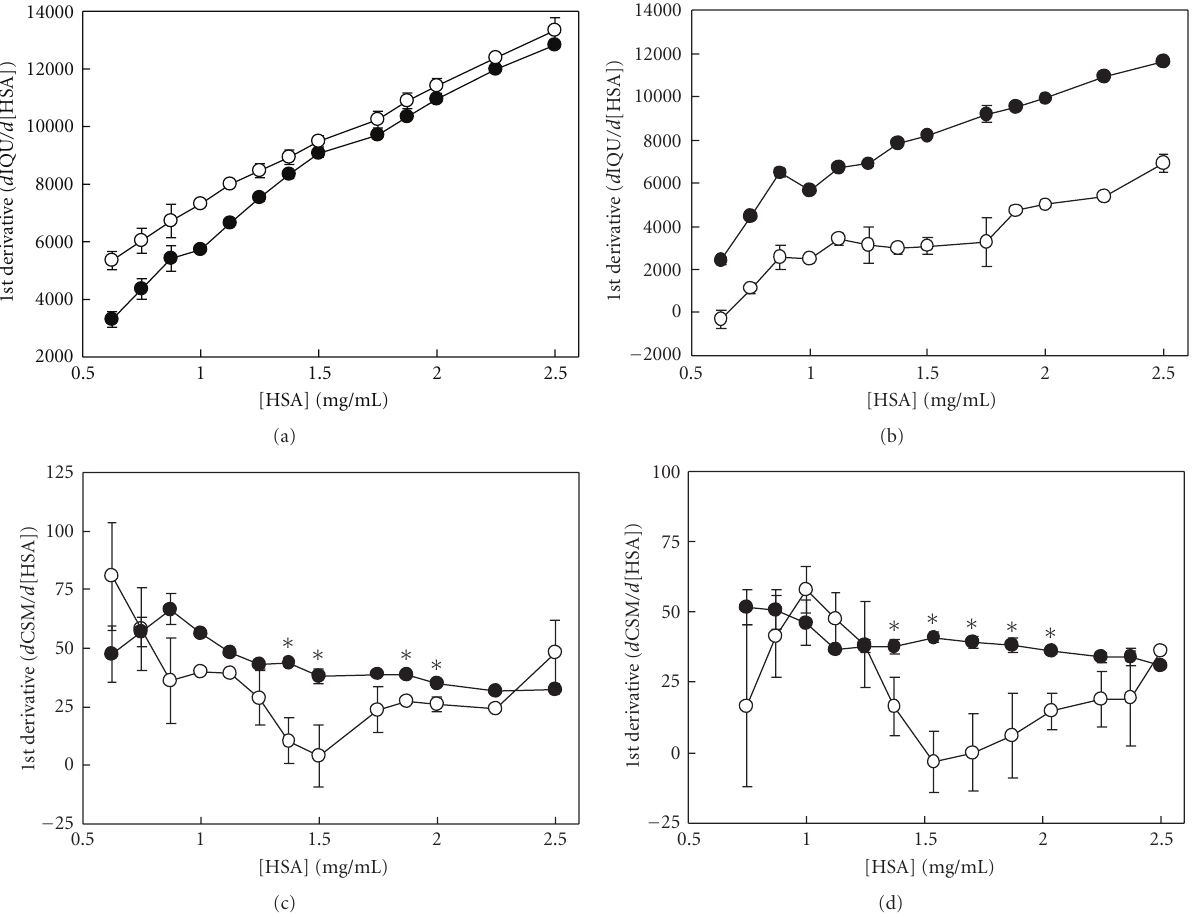
Figure 3: E ff ects of sevoflurane and isoflurane on the first derivatives of CSM and IQU. HSA was treated with (open circles) and without (filled circles) sevoflurane (a) and (c) and isoflurane (b) and (d) prior to measuring fluorescence spectra and determining the first derivatives of IQU (a) and (b) and CSM (c) and (d). Data were from four independent experiments and presented as M ± SEM. Asterisks indicate di ff erences ( P < . 05) due to anesthetic agent.